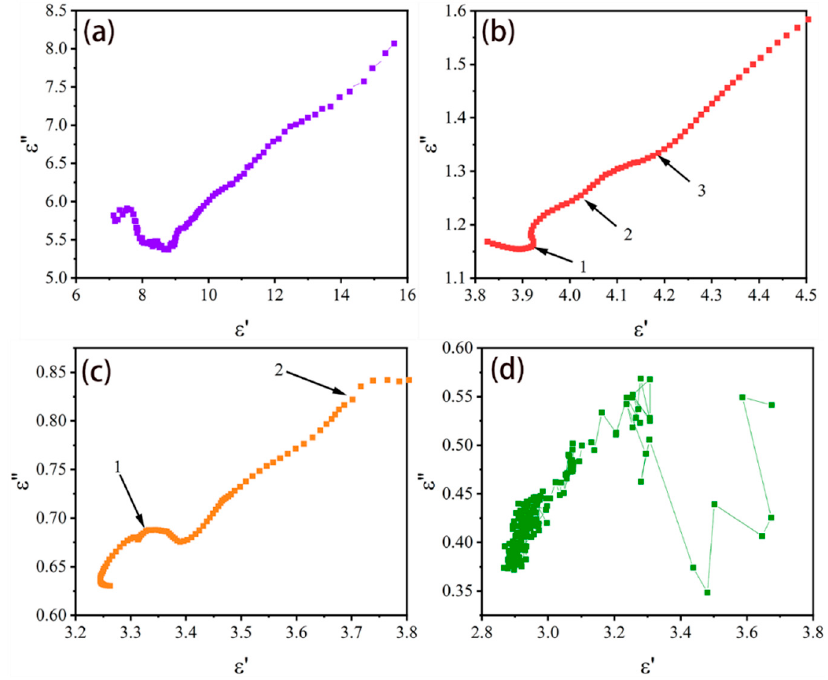
Figure 8. Cole-Cole semicircles of PPy/HSB-0.3 ( a ), PPy/HSB-0.6 ( b ), PPy/HSB-1.2 ( c ) and PPy/HSB-1.8 ( d ).